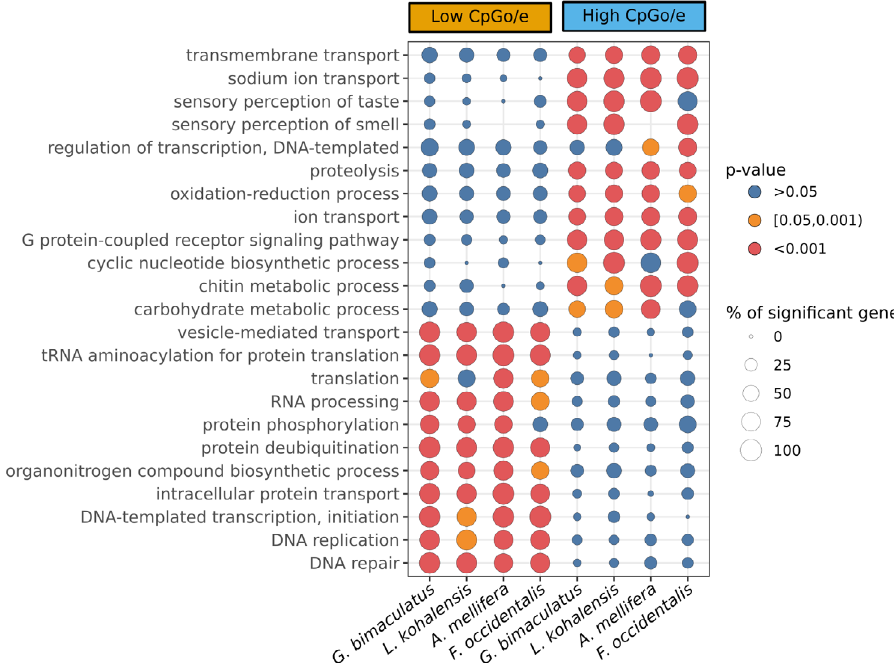
Fig. 3 Functional differences between high- and low- CpG o/e genes. Enriched GO terms with a p value <0.00001 in at least one of the eight categories, which are high CpG o/e and low CpG o/e genes of G. bimaculatus , L. kohalensis , F. occidentalis , and A. mellifera , respectively. The dot diameter is proportional to the percentage of signi fi cant genes with that GO term within the gene set. The dot color represents the p value level: blue >0.05, orange [0.05, 0.001), red <0.001. Extended fi gure with all signi fi cant GO terms ( p value <0.05) available as Supplementary Fig.